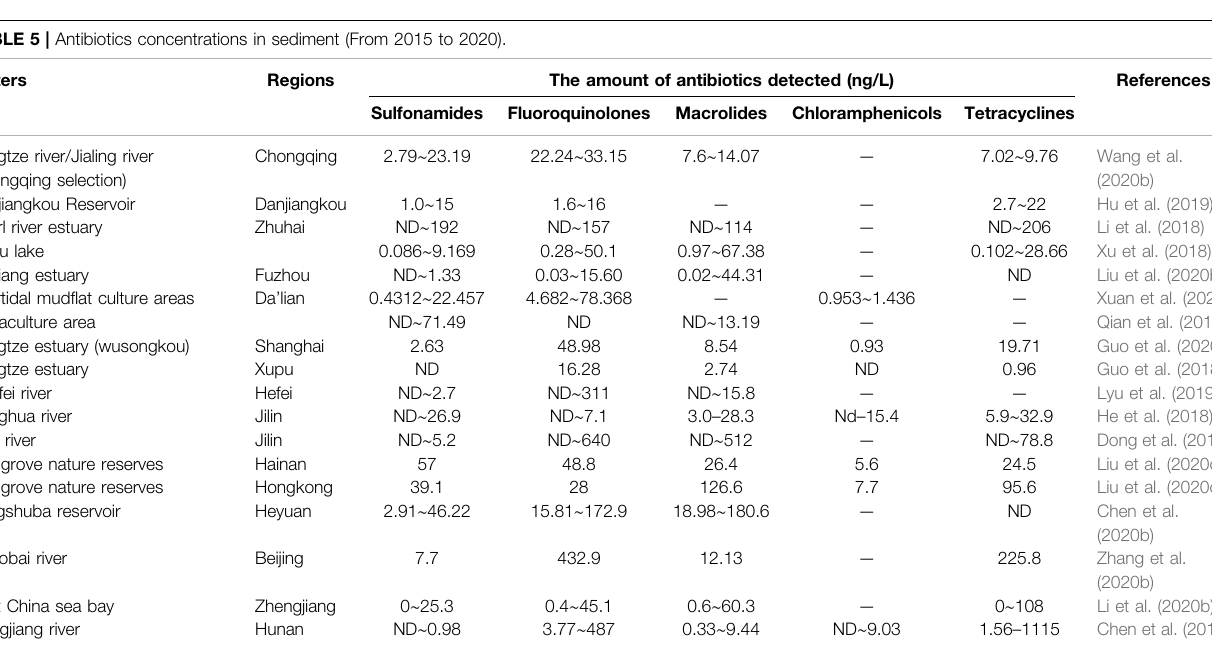
Frontiers in Environmental Science |